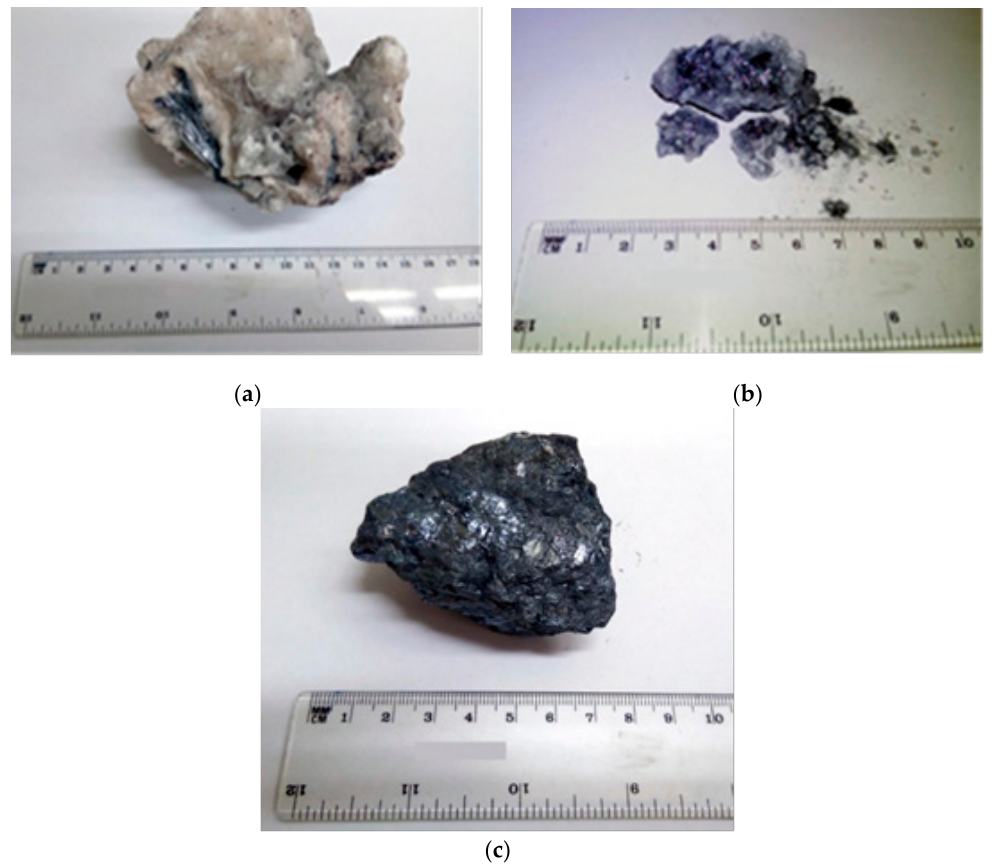
Figure 2. Stibnite onto calcite and quartz from Stratoni/Mantem Lakkos ( a ); and boulangerite, also onto calcite and quartz, from Olympiada ( b ); Stibnite ore from Kilkis ( c ).